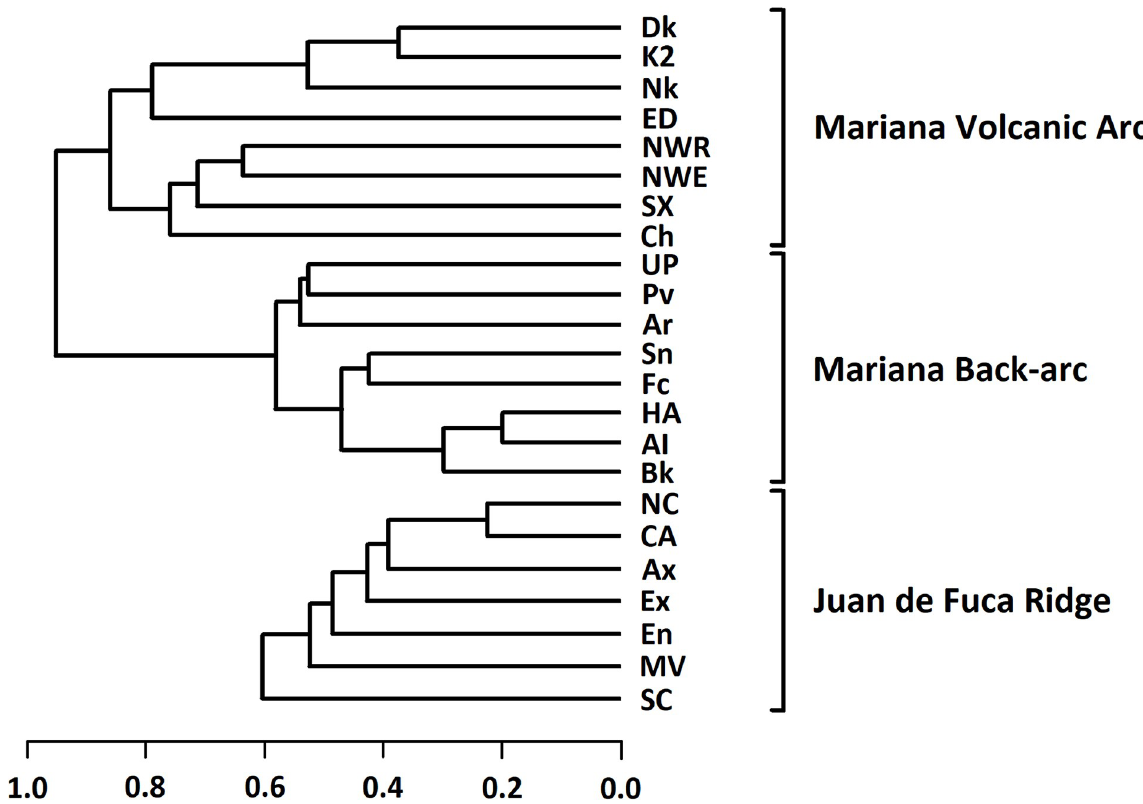
Fig 2. Dendrograms of hydrothermal vent macrofauna assemblages in the Mariana region and Juan de Fuca ridge. Dendrograms illustrating the relative dissimilarity ( β -diversity using the Jaccard Index) of vent sites in each of the three vent systems investigated in this study. Site name abbreviations match those in Table 3. The Mariana systems are illustrated by a single dendrogram because they share six species. No species are shared across the North Pacific.